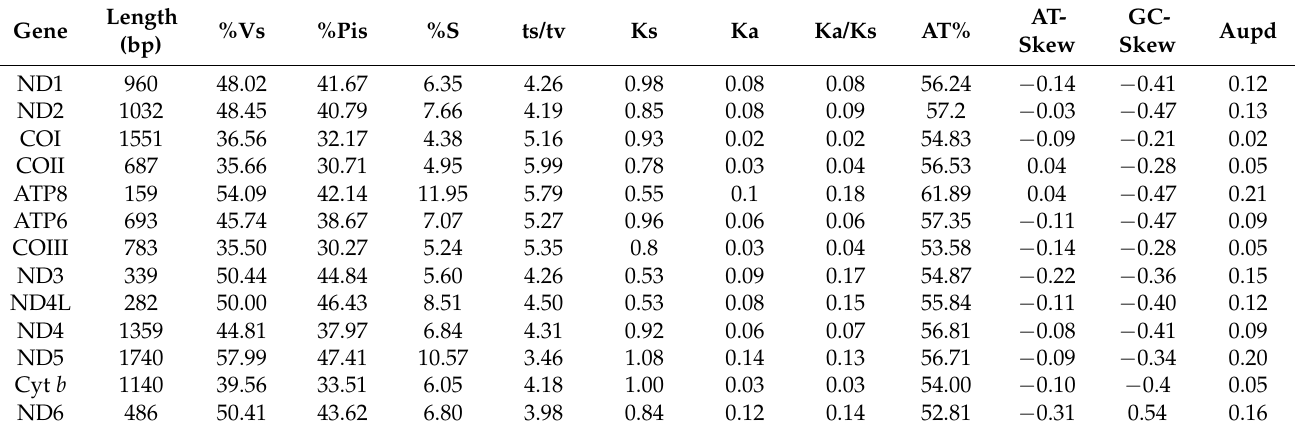
Table 3. Variation analysis and base composition of 13 PCG genes in Rana